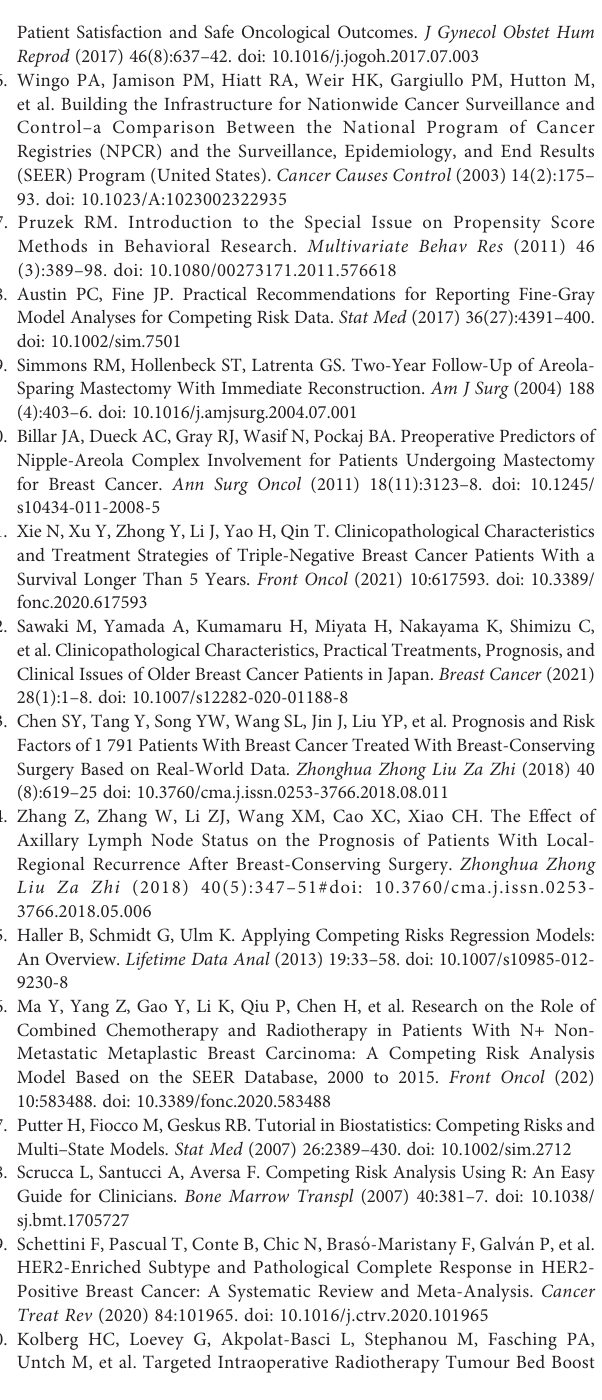
Supplementary Figure 2 | Multivariate Cox regression model forest graph in the original cohort. Supplementary Figure 3 | Cumulative incidence of breast cancer-speci fi c of death (BCSD) and other causes of death (OCSD) in NE-BCT group and NS-BCT group in the original cohort. Supplementary Figure 4 | Kaplan – Meier survival analysis for NE-BCT and NS- BCT female breast cancer patients between 2010 and 2015 before PSM.